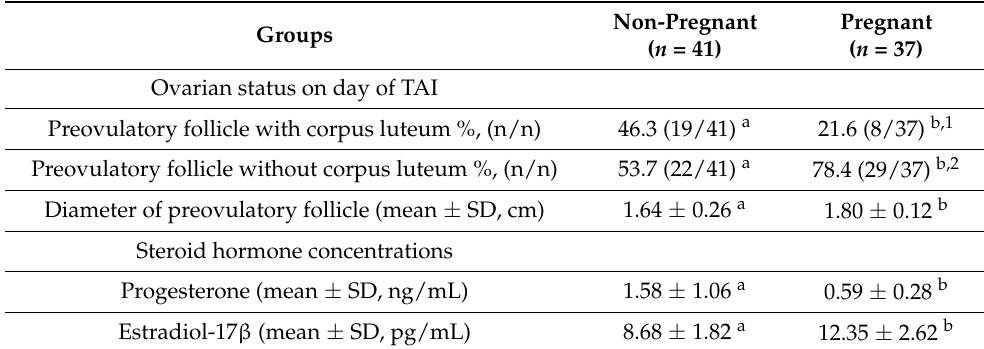
Table 2. Ovarian status and steroid hormone concentration on day of TAI according to pregnancy status of the